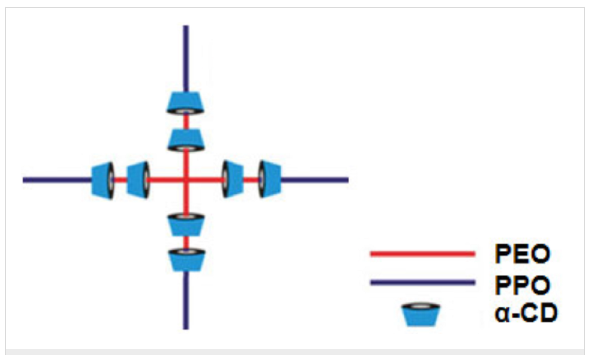
Figure 1: Inclusion complex (polypseudorotaxane) between α -cyclodextrins and reverse